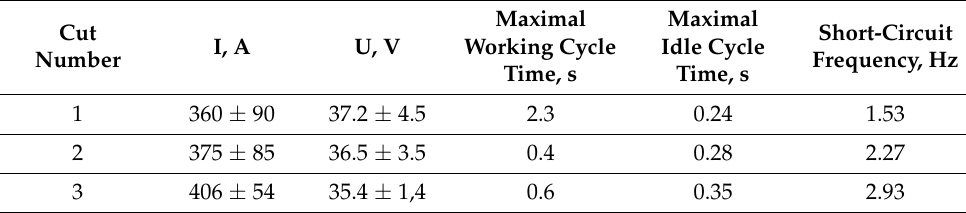
Table 6. Parameters of underwater wet cutting of CuAl5 alloy with PPR-APL1-2 wire.